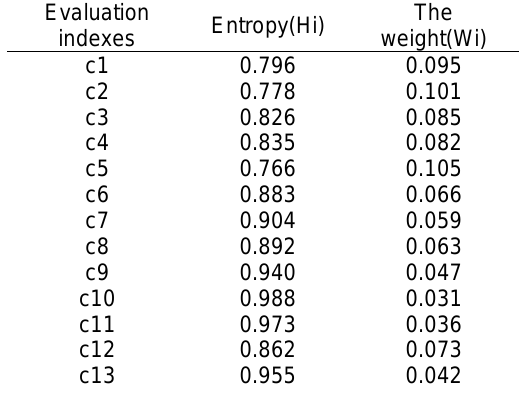
Table 6. Entropy and weight calculation results